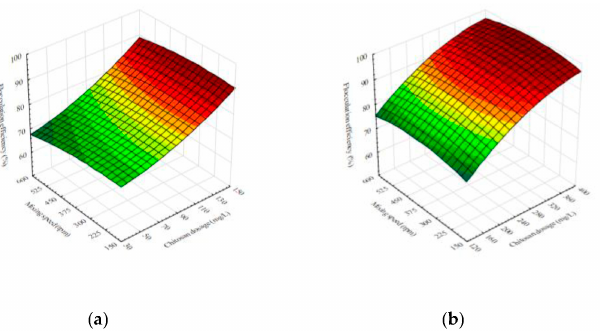
Figure 1. Response surface illustrating the interaction effects of factors on the flocculation efficiency of Bacillus sp. BioSol021 flocculation using chitosan in ( a ) cheese whey effluent and ( b ) winery flotation effluent.